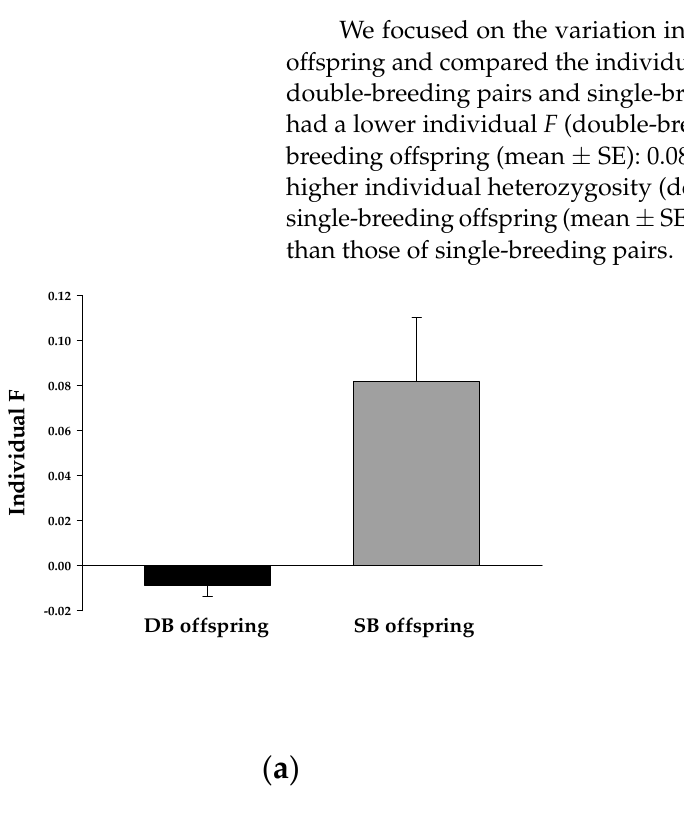
Figure 3. ( a ) Individual F of double-breeding (DB) and single-breeding (SB) offspring, and ( b ) individual heterozygosity of double-breeding (DB) and single-breeding (SB) offspring: the results are presented as the means and SE for each group.